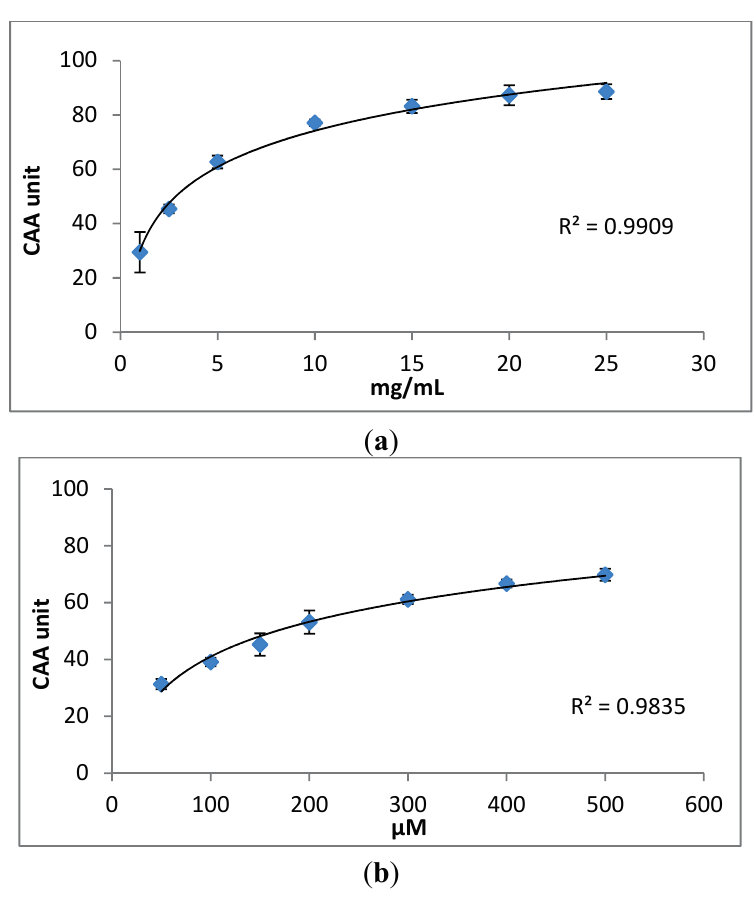
Figure 3. Dose–response curves for inhibition of peroxyl radical-induced DCFH oxidation by ( a ) S. oleraceus leaf extracts and ( b ) chlorogenic acid. The data were expressed as CAA unit indicating the intra-cellular antioxidant activity of samples. The curves shown are each from a single experiment (mean ± SD, n =